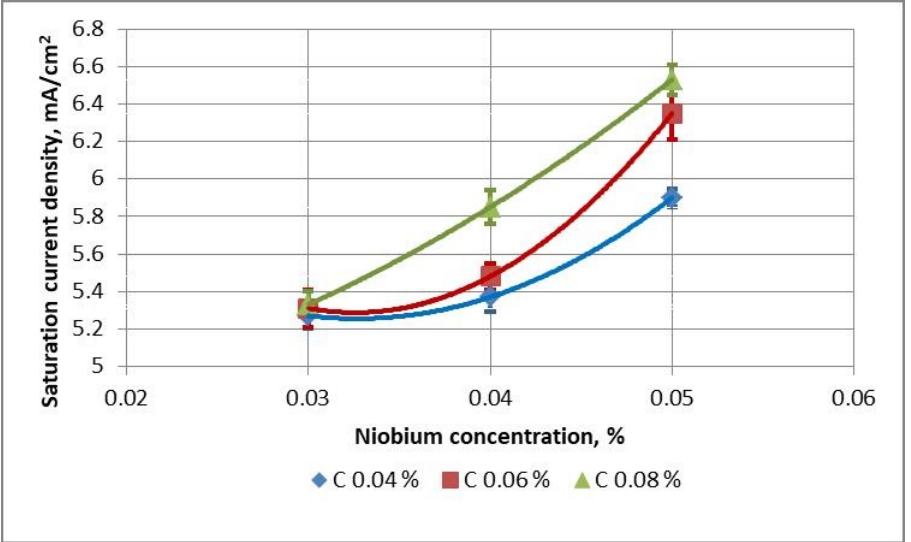
Figure 4. Dependence of the saturation current density on the niobium content at various carbon content.